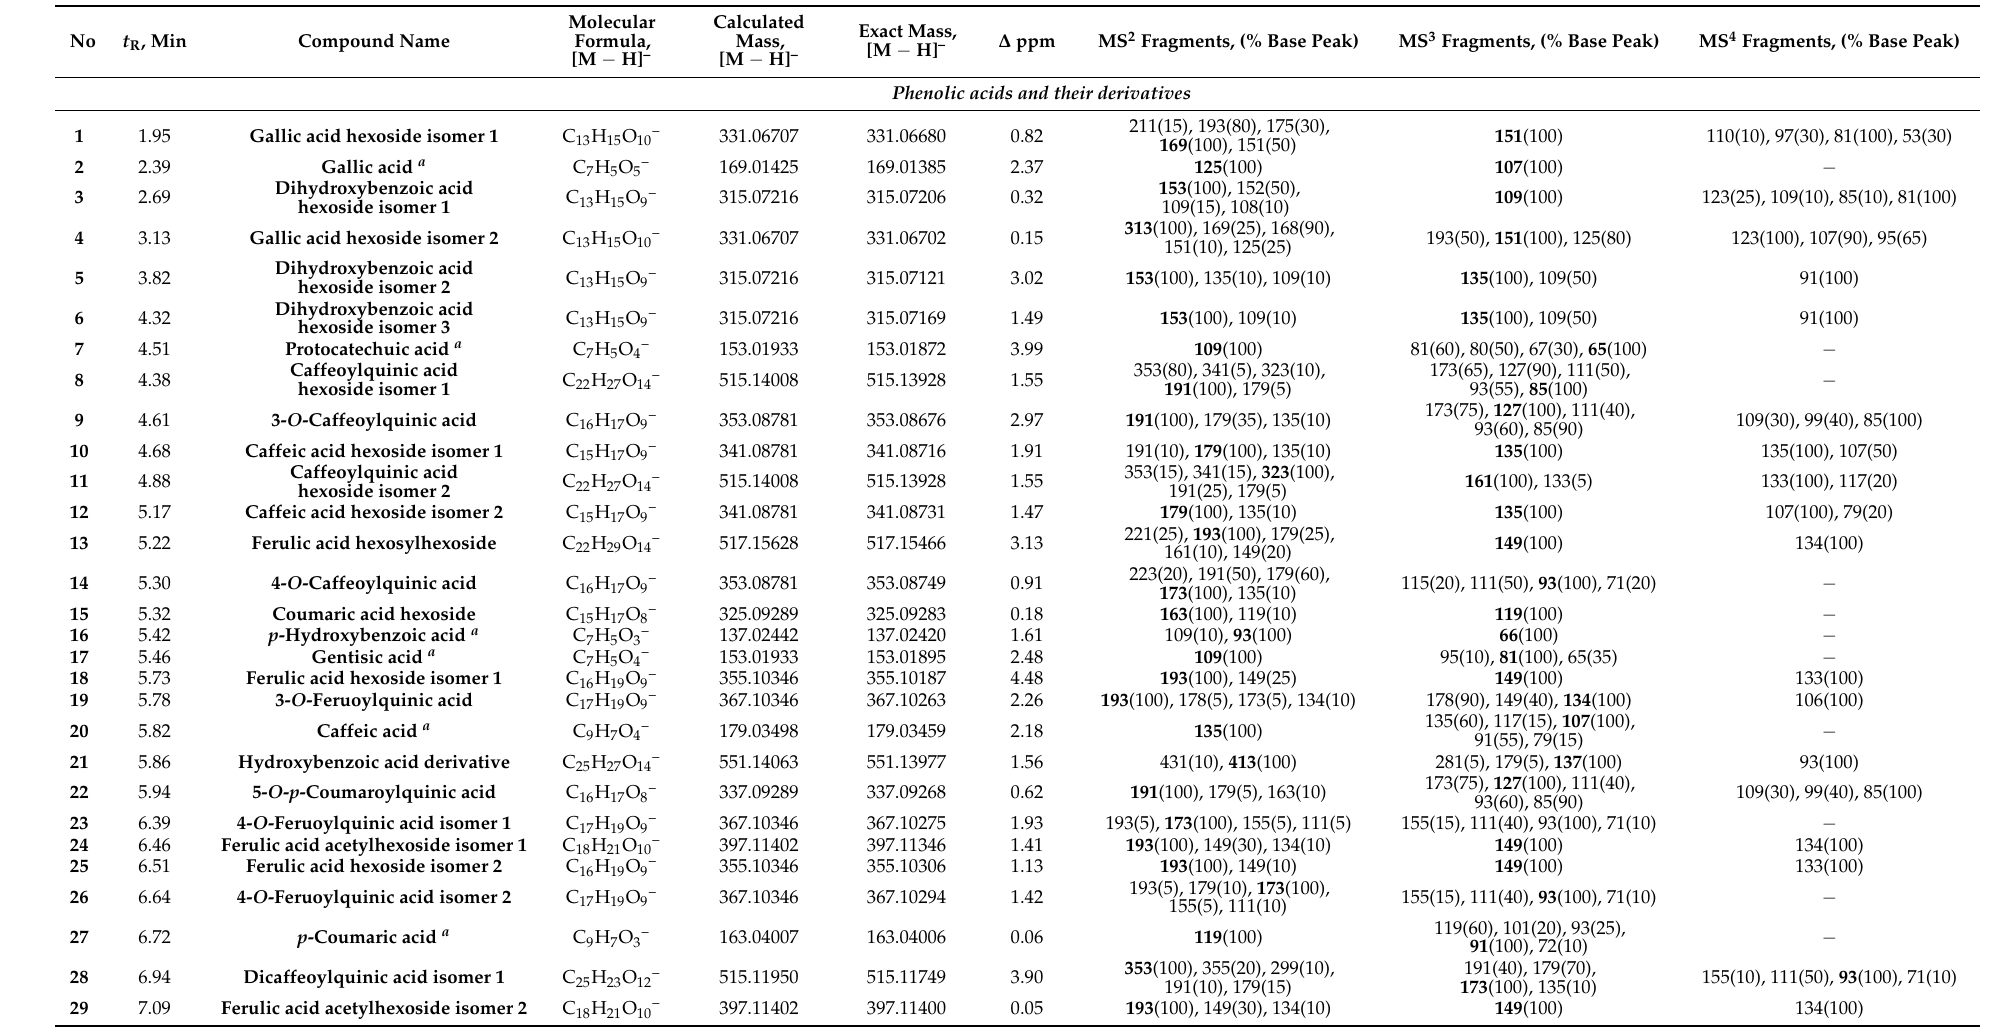
Table 1. Compounds identified in chamomile